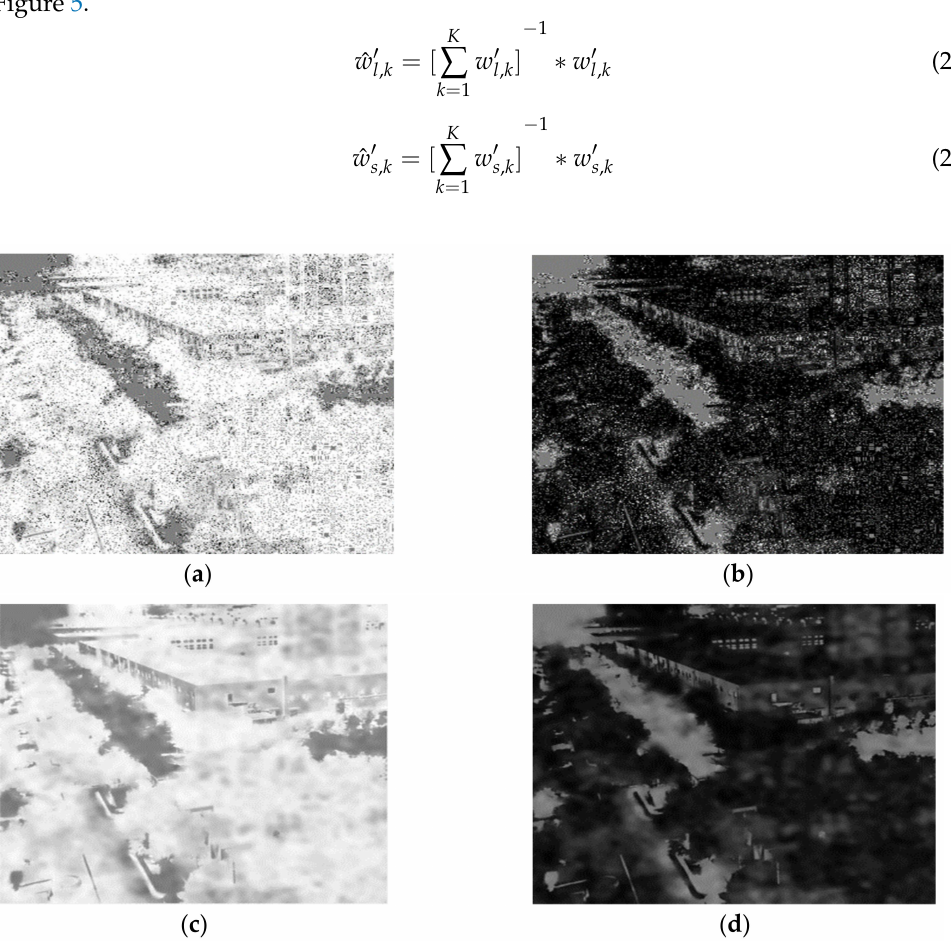
Figure 5. An example of weight maps refinement. ( a ) the low-rank weight map; ( b ) the saliency weight map; ( c ) the refined low-rank weight map; ( d ) the refined saliency weight